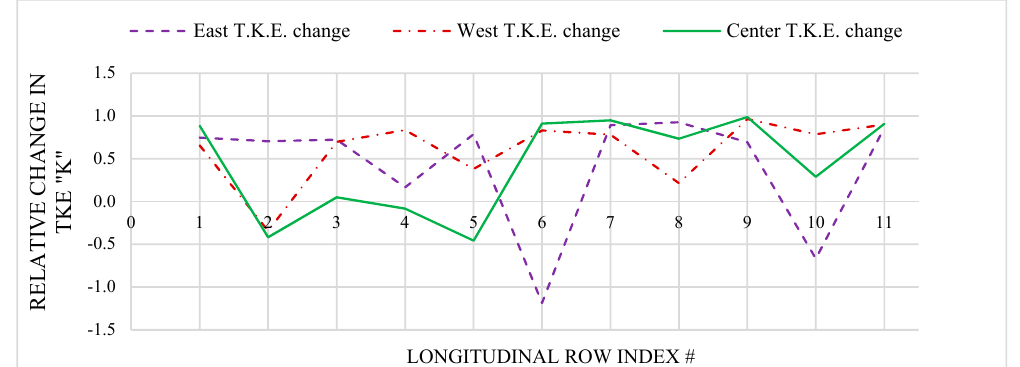
Figure 12. Relative change in k between heated and unheated manikins.